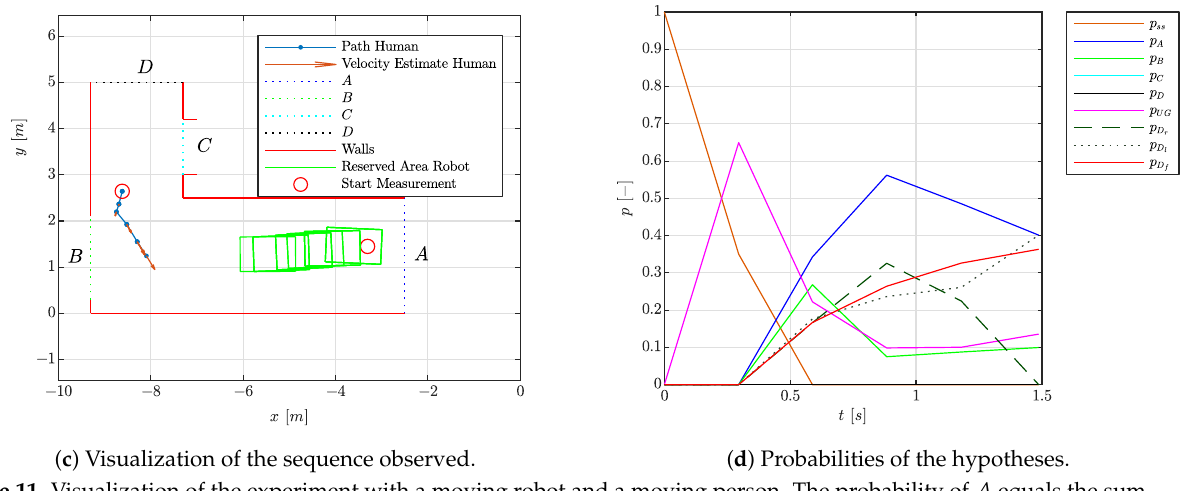
( c ) Visualization of the sequence observed. ( d ) Probabilities of the hypotheses. Figure 11. Visualization of the experiment with a moving robot and a moving person. The probability of A equals the sum of the probability of passing the robot on the left or right side. The detection originates from